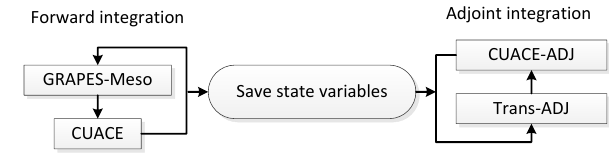
Figure 4. Operational processes of the GRAPES–CUACE aerosol